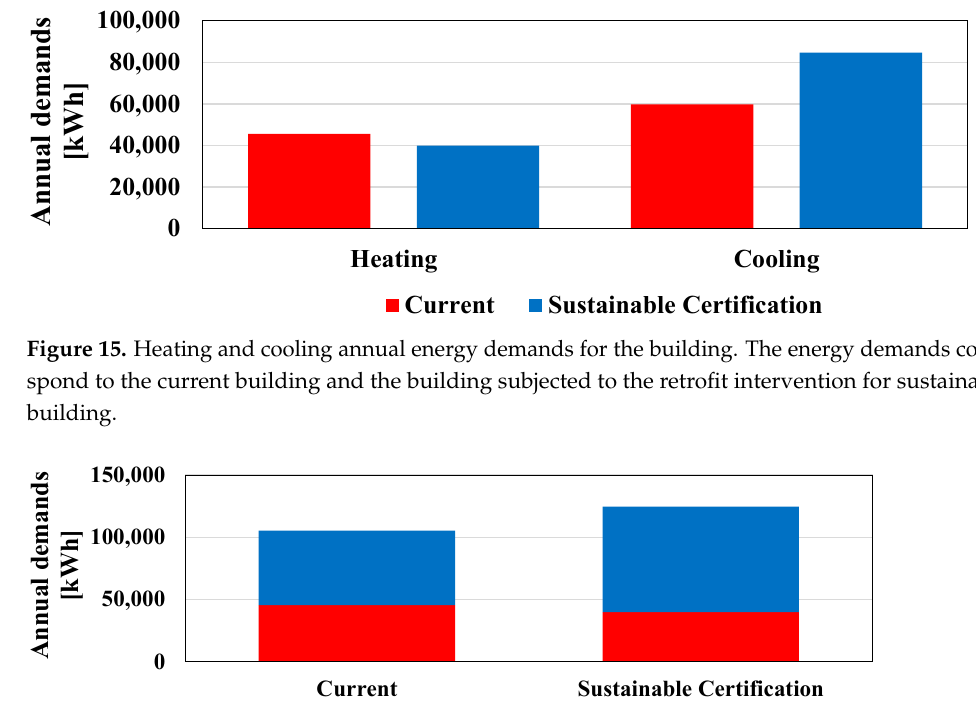
Figure 15. Heating and cooling annual energy demands for the building. The energy demands cor- respond to the current building and the building subjected to the retro fi t intervention for sustainable building.